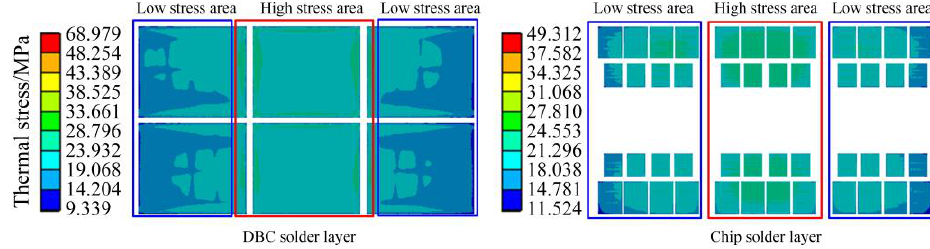
Figure 14. Thermal stress of the solder layer.